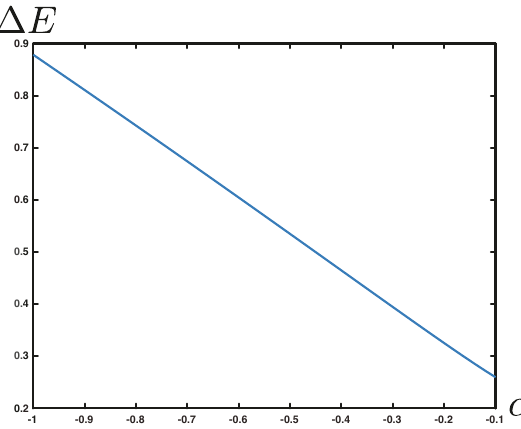
Figure 3 . The gap ∆ E (in units where J = 1 ) for negative α calculated from the exponential decay of the solutions to the DS equations. We obtain the gap by linear fitting log | G 11 | in regime 1 (cid:28) τ (cid:28) β , where the solution is dominated by the exponential decay, and the exponent is J dominated by ∆ E at zero